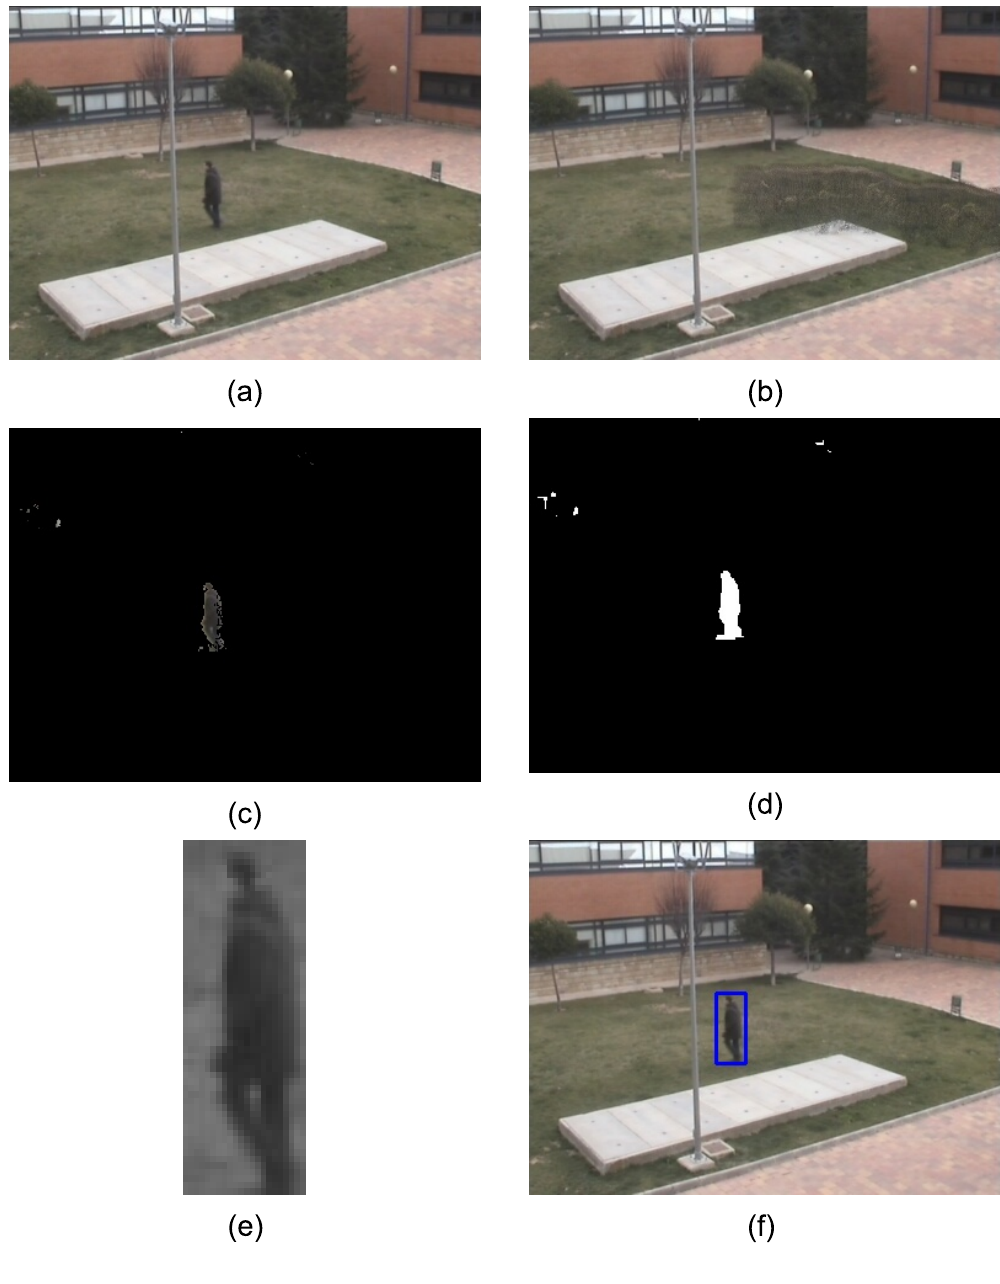
Figure 5. Stages of the background segmentation algorithm. ( a ) Original input frame; ( b ) background model calculated; ( c ) foreground image calculated; ( d ) foreground image after binarization; ( e ) ROI extracted from the original image; ( f ) final